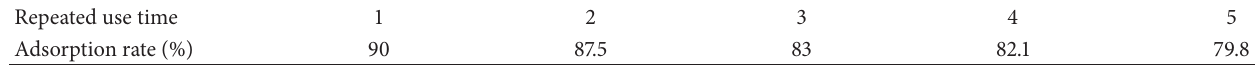
Table 3: Relationship between adsorption rate and time of Fe 3 O 4 @MIP repeated use.